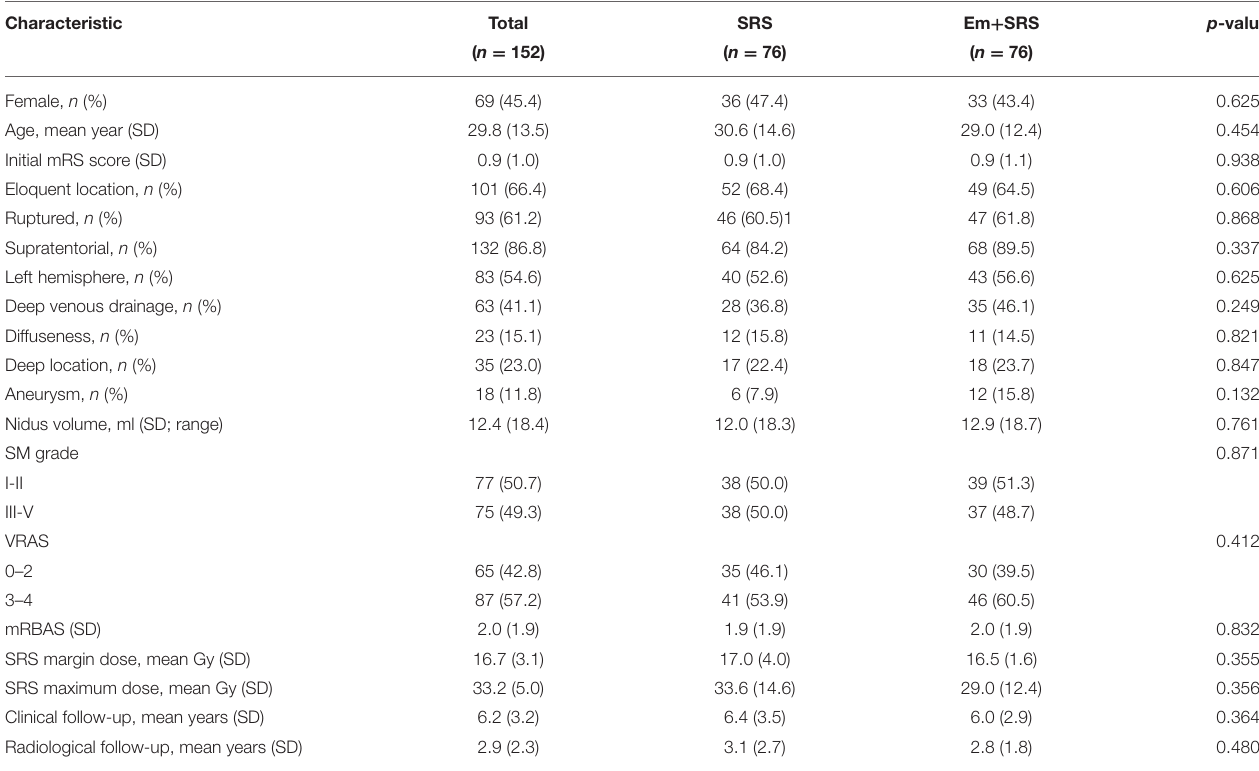
TABLE 1 | Baseline characteristics of the whole cohort.